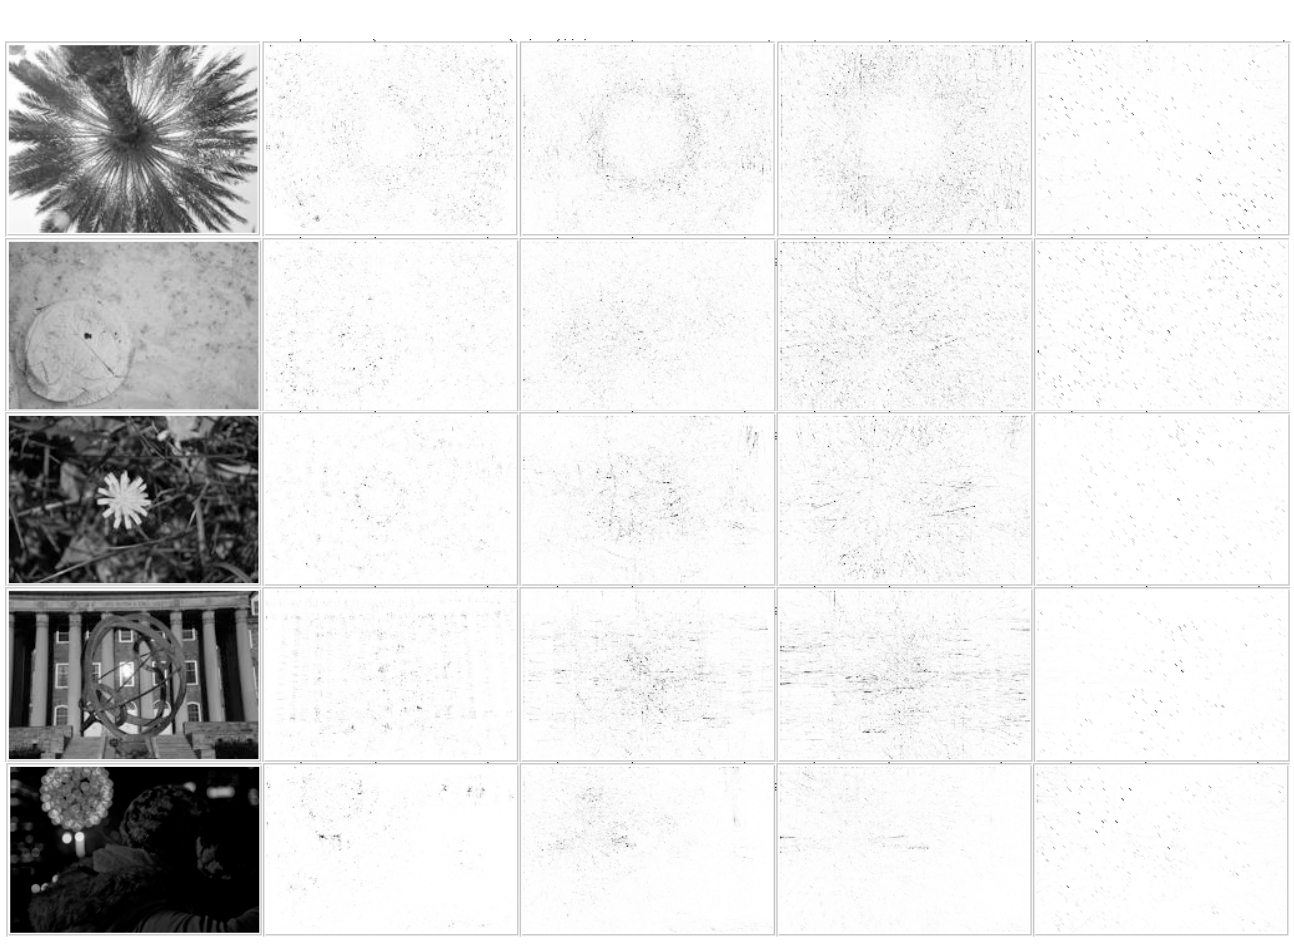
Figure 8a . Original images and the resulting fast radial symmetry transform maps of ranges 8,32,64,128